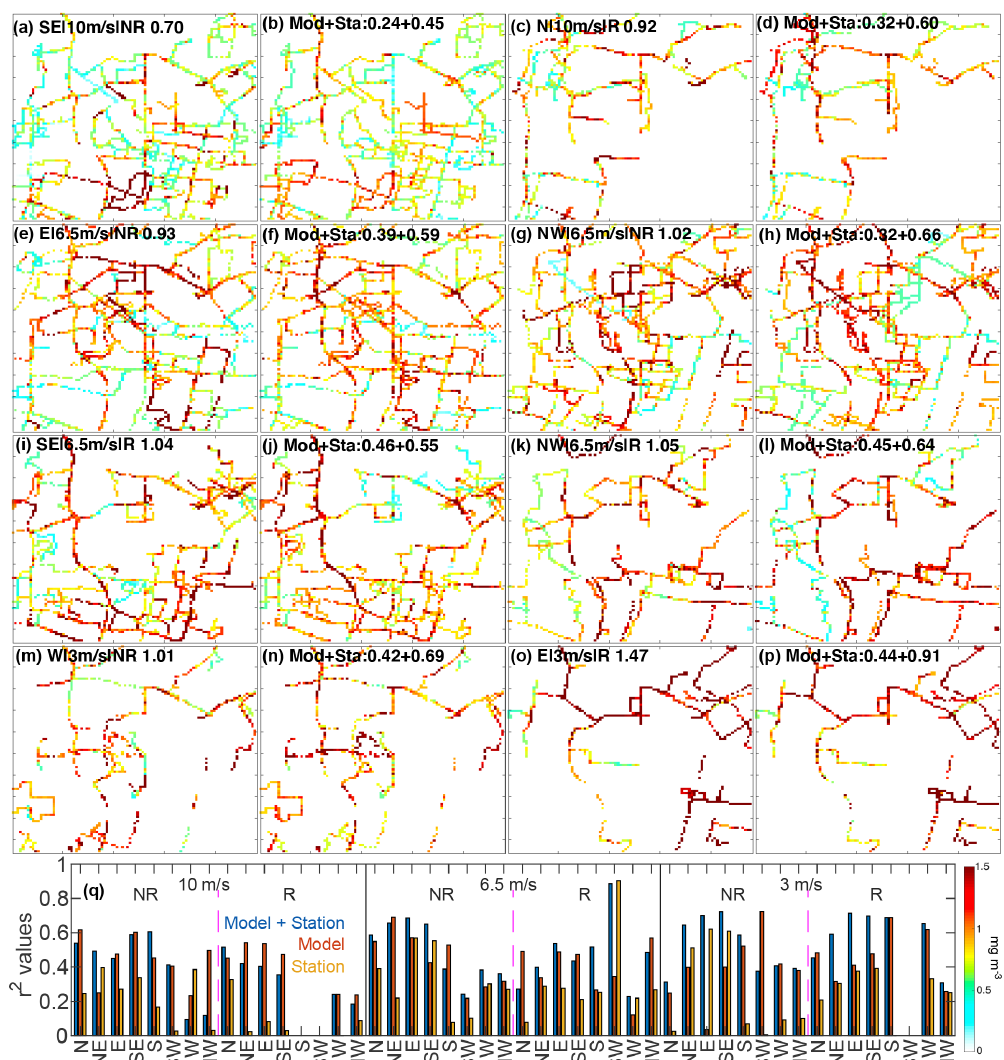
Figure 6. Comparison between taxi-sensor-measured (odd columns) and modeled (even columns) ground-level CO concentrations for se- lected combinations of wind speed, directions, and rush/non-rush hours. As the taxi sensor data have a temporal resolution of 10s (roughly equivalent to 100m given an average vehicle speed of 40kmh − 1 ), both the measurements and model results are regraded to a 100m res- olution grid. The wind and emission information is shown at the top of the panels in this format: “wind direction | wind speed | emission level r ush or n on- r ush hours”. The mean of the data is shown at the top of each panel, with the modeled one as the sum of the model output and regional background from national stations. Panel (q) shows the coefficients of determination ( r 2 ) of a linear regression between taxi sensor data and model/station data under different emission and meteorological conditions. Blue bars represent the regression between measured and model + regional background, while red and yellow bars are for the measured vs. model only and measured vs. station data only, respectively. Note the color bar for panels (a) – (p) is in panel (q)